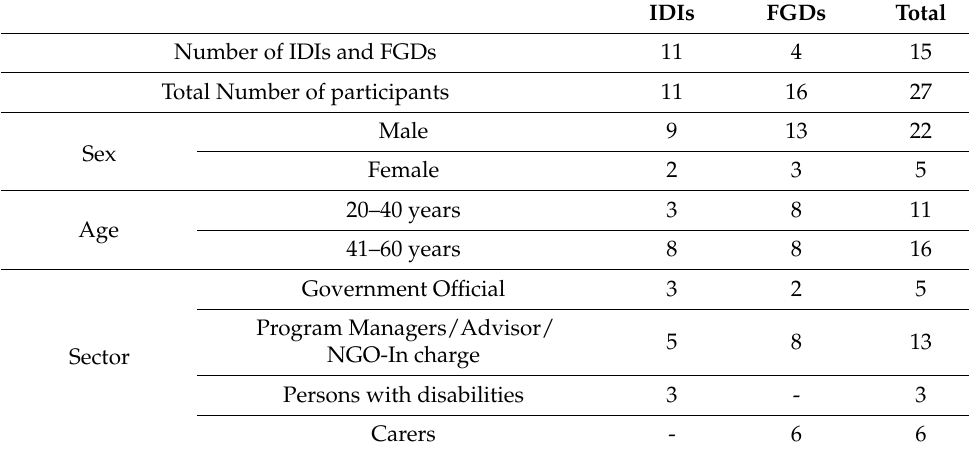
Table 5. Profile of In-depth Interviewees and Focus Group Discussion